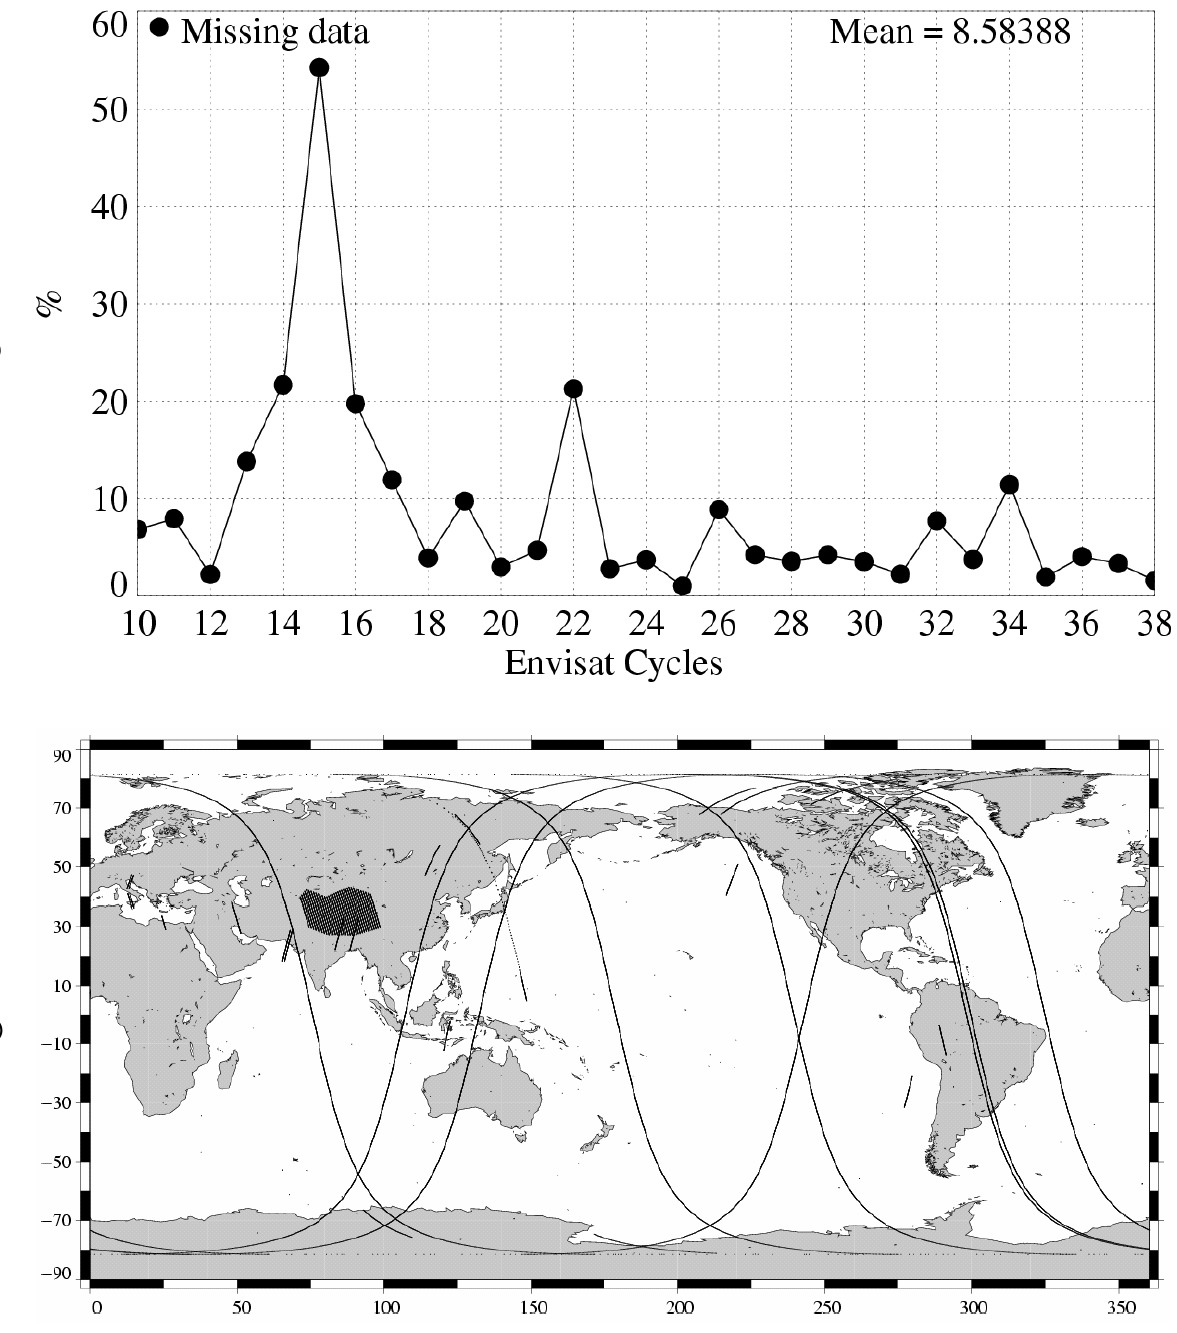
Figure 1. a) Monitoring of the percentage of missing measurements relative to what is theoretically expected over ocean. b) Envisat missing measurements for cycle